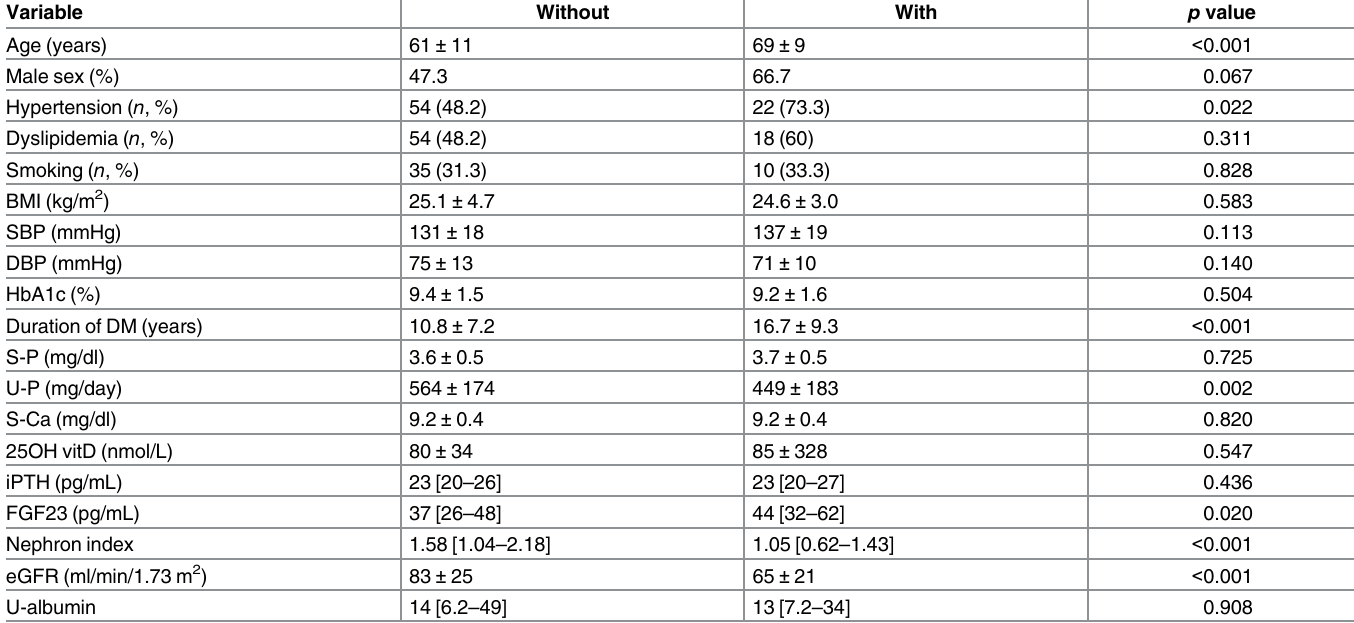
Table 2. Differences in clinical parameters in subjects with ( n = 30) and without ( n = 112) macroangiopathy BMI, body mass index; DBP, diastolic blood pressure; DM, diabetes mellitus; eGFR, estimated glomerular filtration rate; FGF23, fibroblast growth factor 23; HbA1c, hemoglobin A1c; iPTH, intact parathyroid hormone; 25OH vitD, 25-hydroxyvitamin D3; SBP, systolic blood pressure; S-Ca, serum calcium; S-P, serum phosphate; U-albumin, urinary albumin; U-P, 24-h urinary excretion of phosphate.